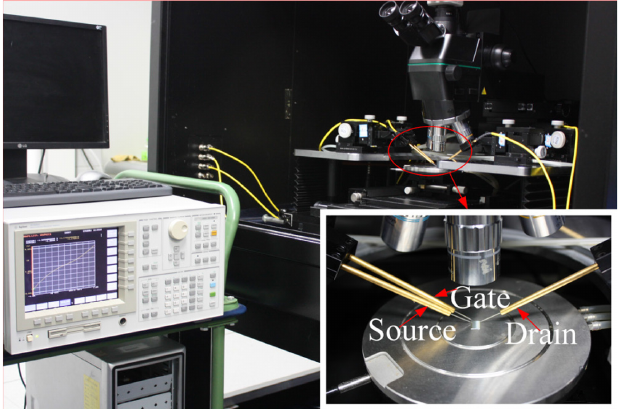
Figure 12. SWCNT-graphene FET electrical characterization system.